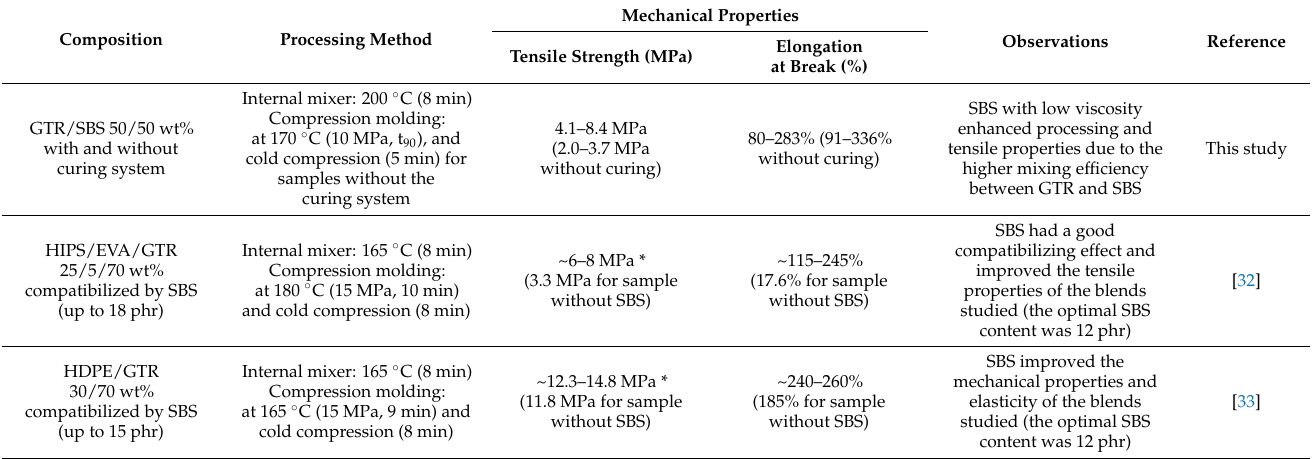
Table 3. Processing methods and tensile properties of thermoplastic composites modified with waste rubber and SBS copolymers described by different research groups.